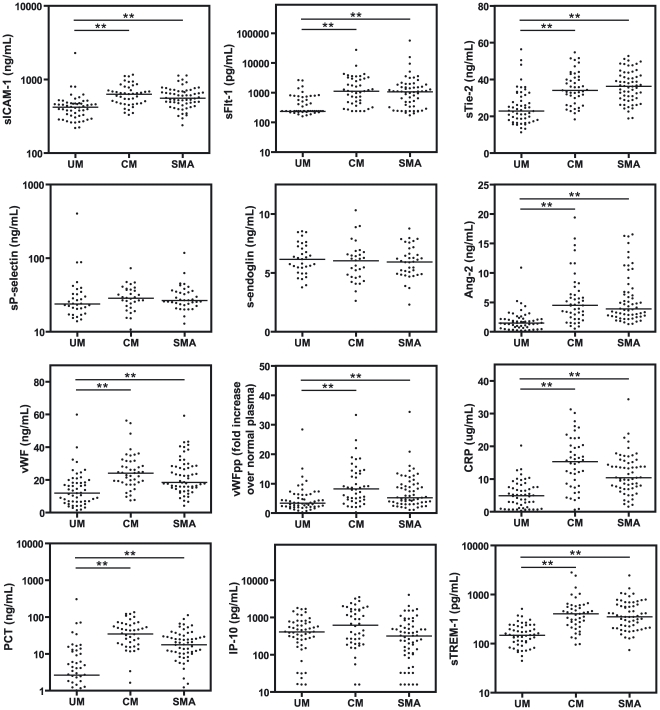
Plasma biomarker levels in Ugandan children with uncomplicated and severe malaria at time of presentation.Biomarkers of inflammation and endothelial activation in the plasma of children with uncomplicated malaria (UM), cerebral malaria (CM), and severe malarial anemia (SMA) were measured by ELISA. Data are presented as dot plots with medians. A Mann Whitney U test was performed for each comparison, and p values were adjusted for multiple comparisons using Holm's correction (n = 24). ** p<0.01.